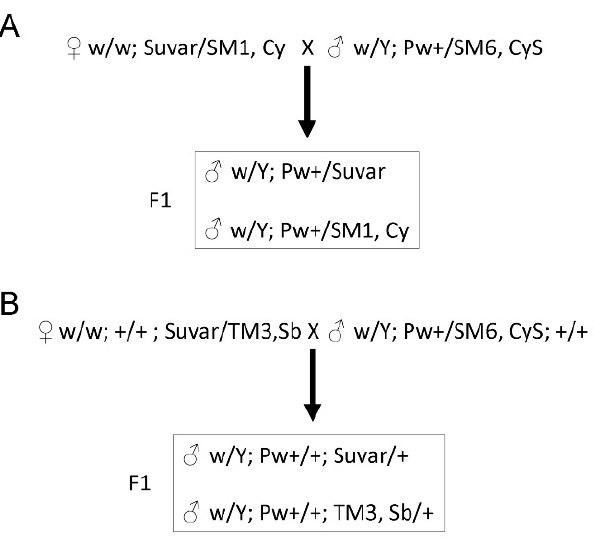
Figure 1. Scheme of genetic crosses. ( A ) Crosses with PEV suppressor mapping to chromosome 2 ( Su(var)205 2 and aubergne QC4 ); ( B ) Crosses with PEV suppressor mapping to chromosome 3 ( Su(var)30 71 and Su(var)3-9 1 ). For a detailed explanation of the crosses see Material and Methods.